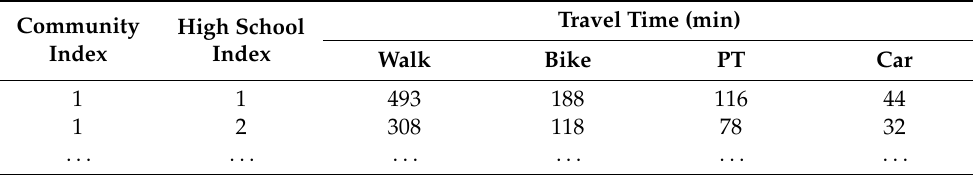
Table 3. Travel time samples.